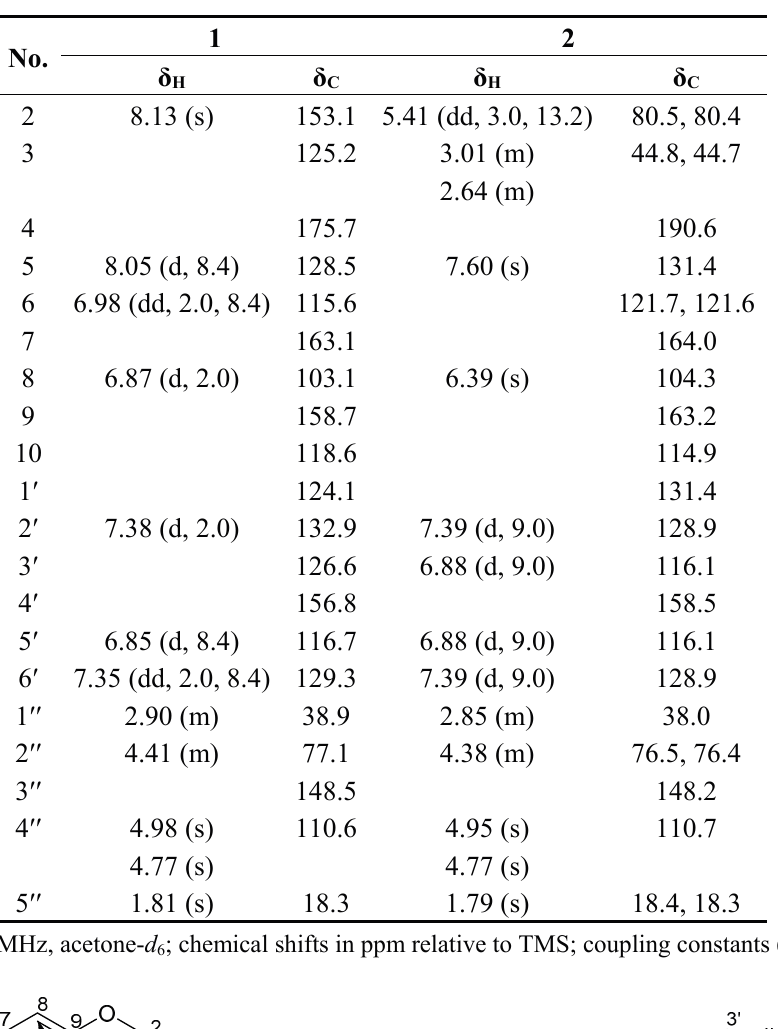
Table 1. 1 H- and 13 C-NMR data of compounds 1 and 2 .